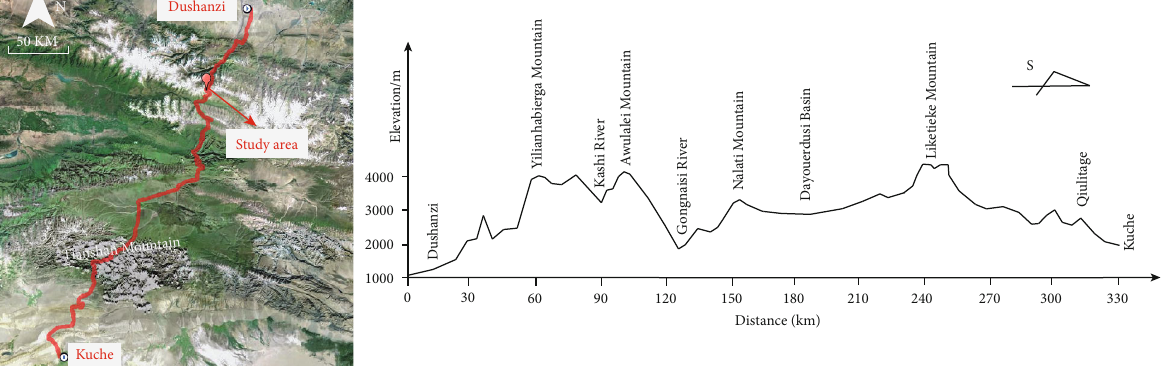
Figure 1: General situation of the Tianshan